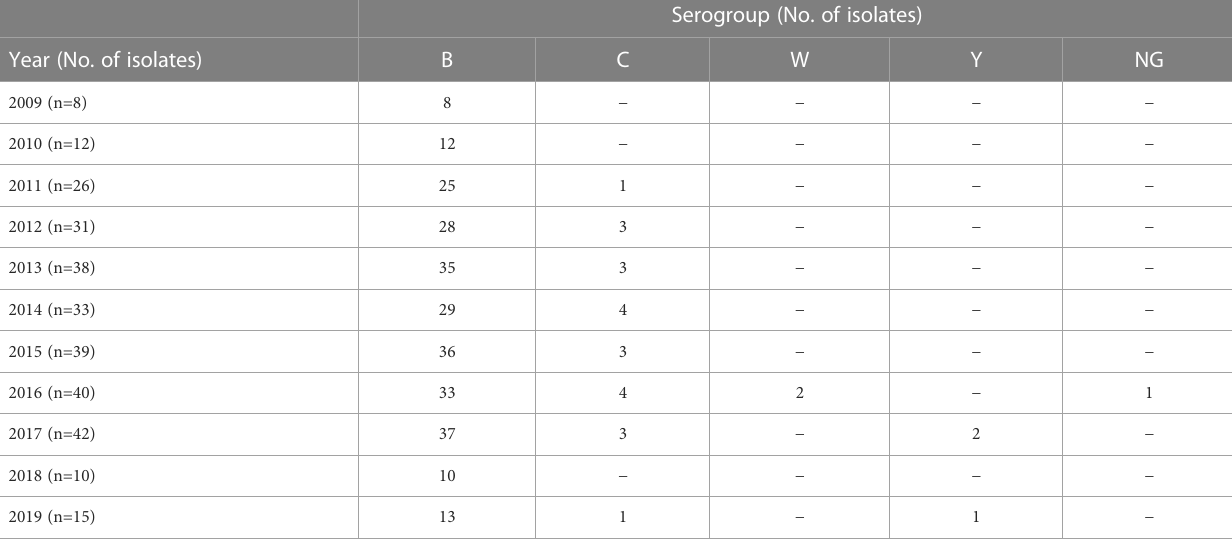
Serogroup (No. of isolates)